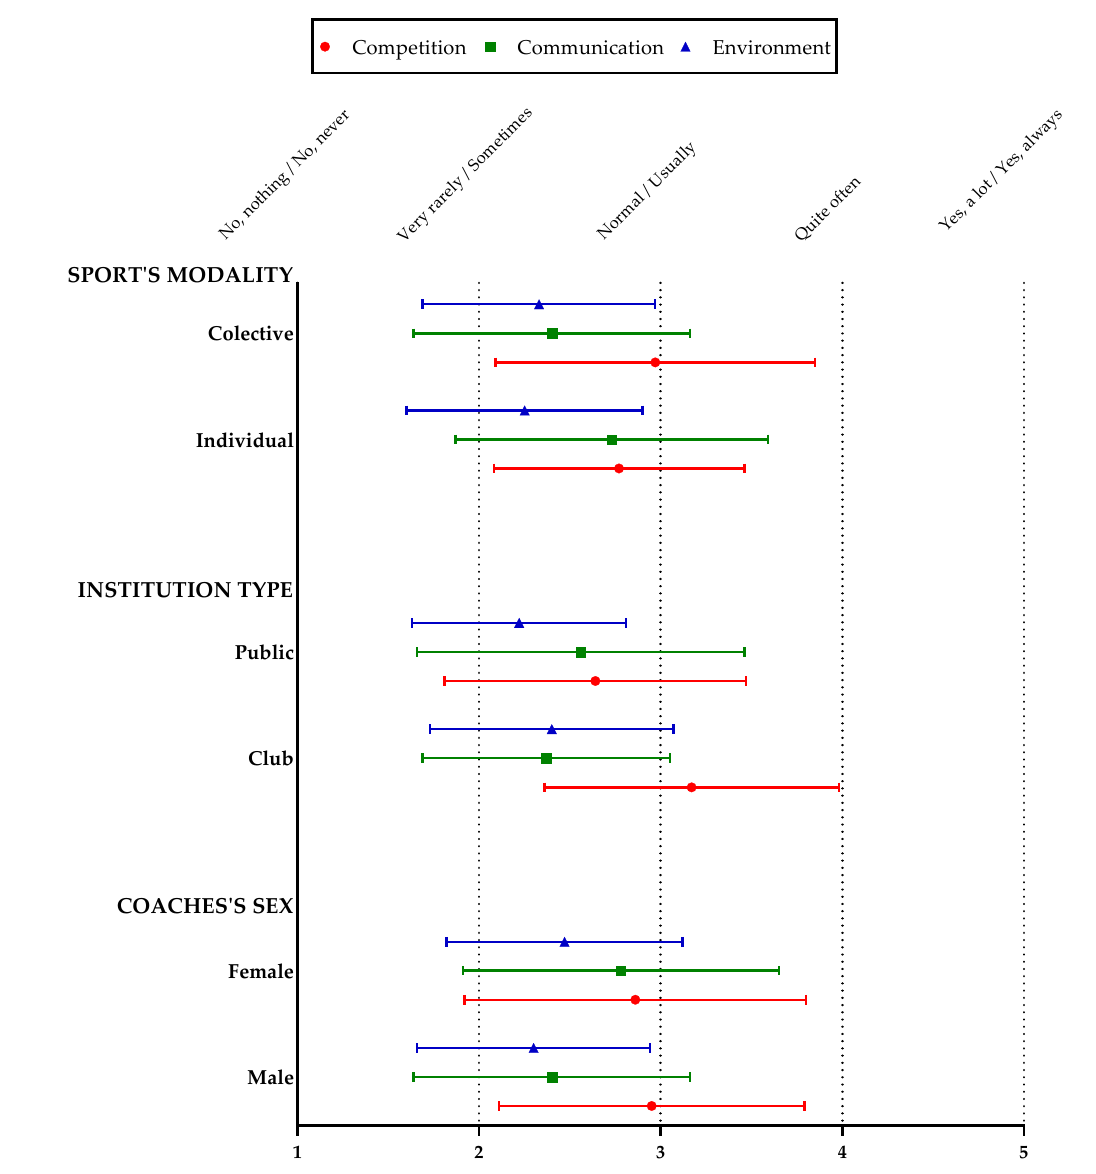
Figure 1. Descriptive results of the independent variables studied for the factors competition attitude, communication with the coach and environment during training sessions.